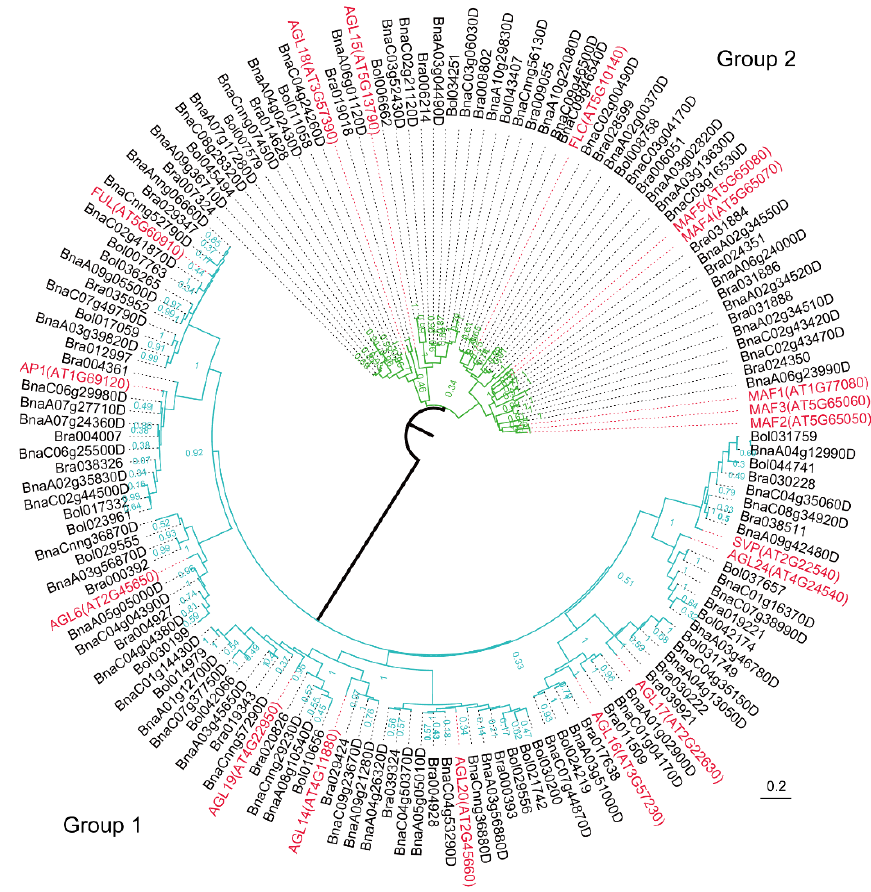
Figure 3. Phylogeny of MADS family proteins in A. thaliana , B. napus , B. rapa , and B. oleracea . The phylogenetic tree was constructed using MEGA 7.0 with the neighbor-joining method (1000 bootstrap replicates) and displayed using FigTree v1.4.0. MADS proteins involved in flowering are clustered into two distinct groups (Group 1, the turquoise clade; Group 2, the green clade). The scale bar denotes the number of nucleotide replacements per site. MADS: MCM1, AGAMOUS, DEFICIENS, and SRF, At : A. thaliana (marked in red), Bra: B. rapa , Bol: B. oleracea , Bna: B. napus .